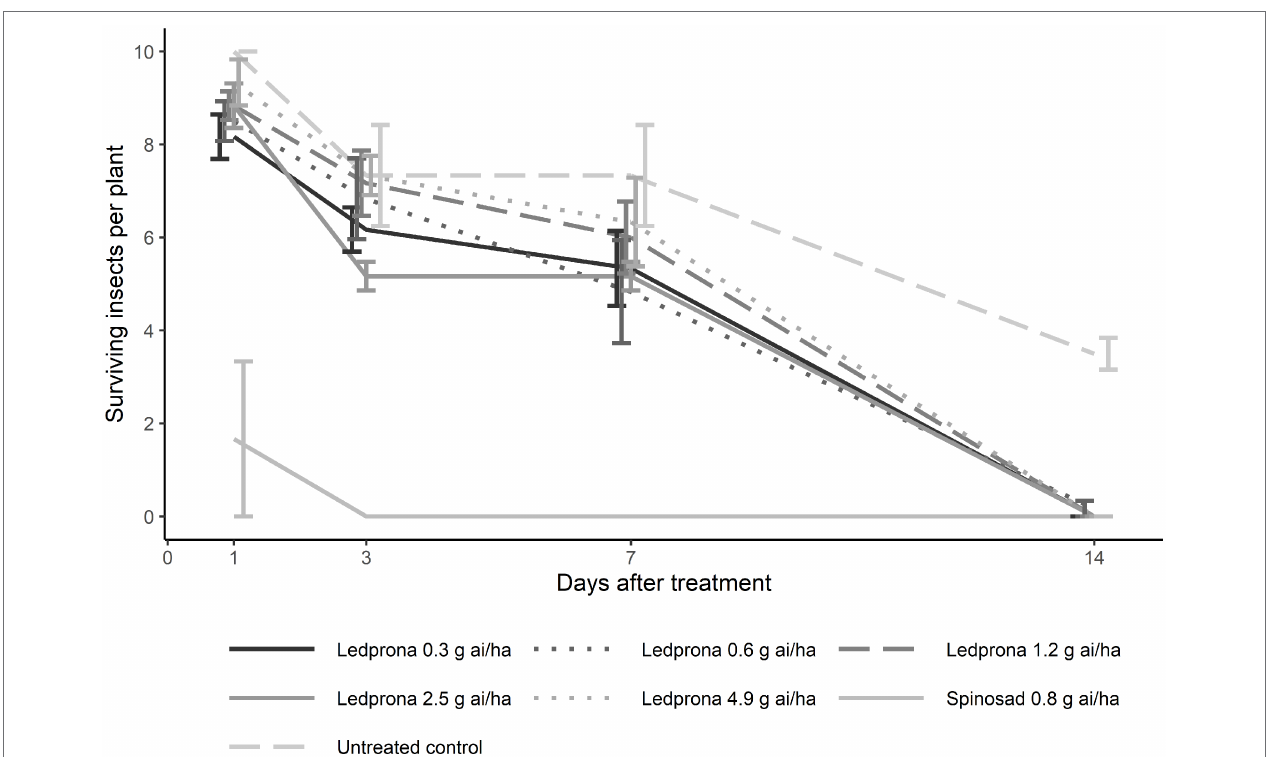
FIGURE 10 | Number of surviving CPB larvae per plant at 1, 3, 7, and 14 days after Ledprona treatment in a greenhouse trial. Line types represent different treatments and error bars represent standard error of the